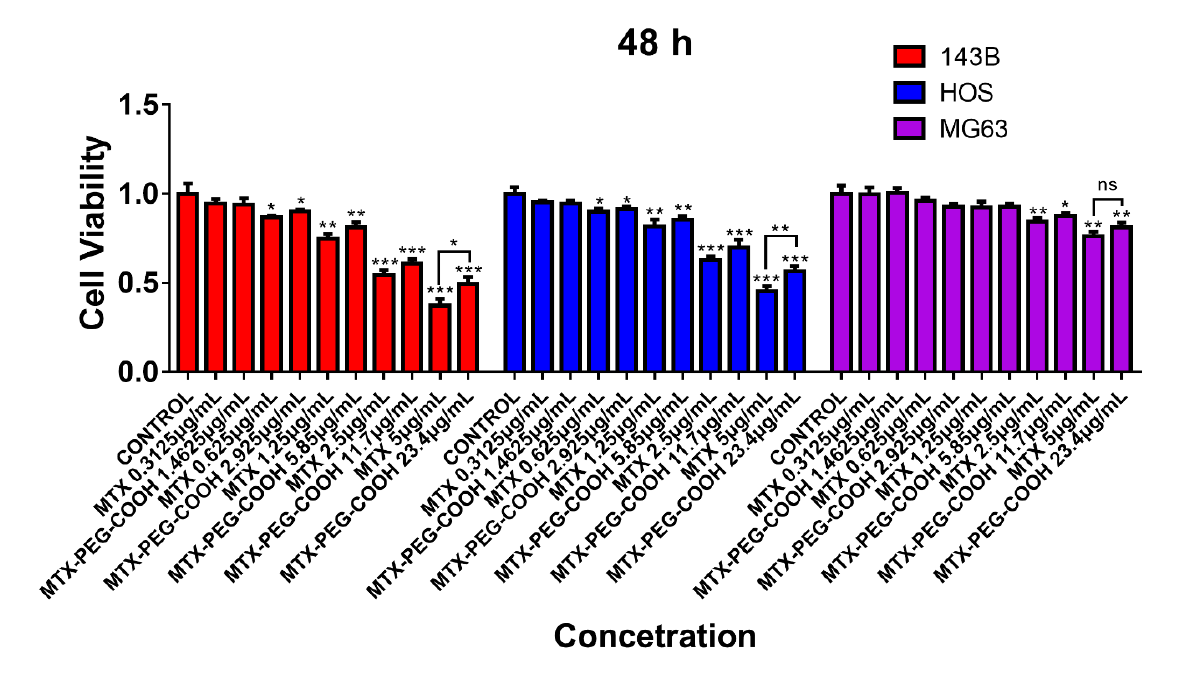
Figure 4. Cytotoxicity evaluation of free MTX and MTX-PEG-COOH at different concentrations on three kinds of osteosarcoma cells. * p < 0.05, ** p < 0.01, *** p < 0.001, represent significant differ- ences, while ns means no statistical difference.